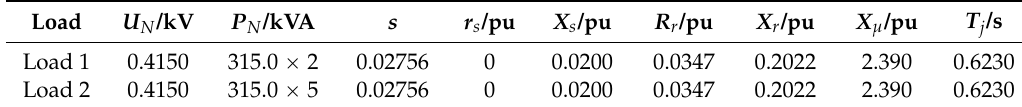
Table A3. Rotor Load Parameters.